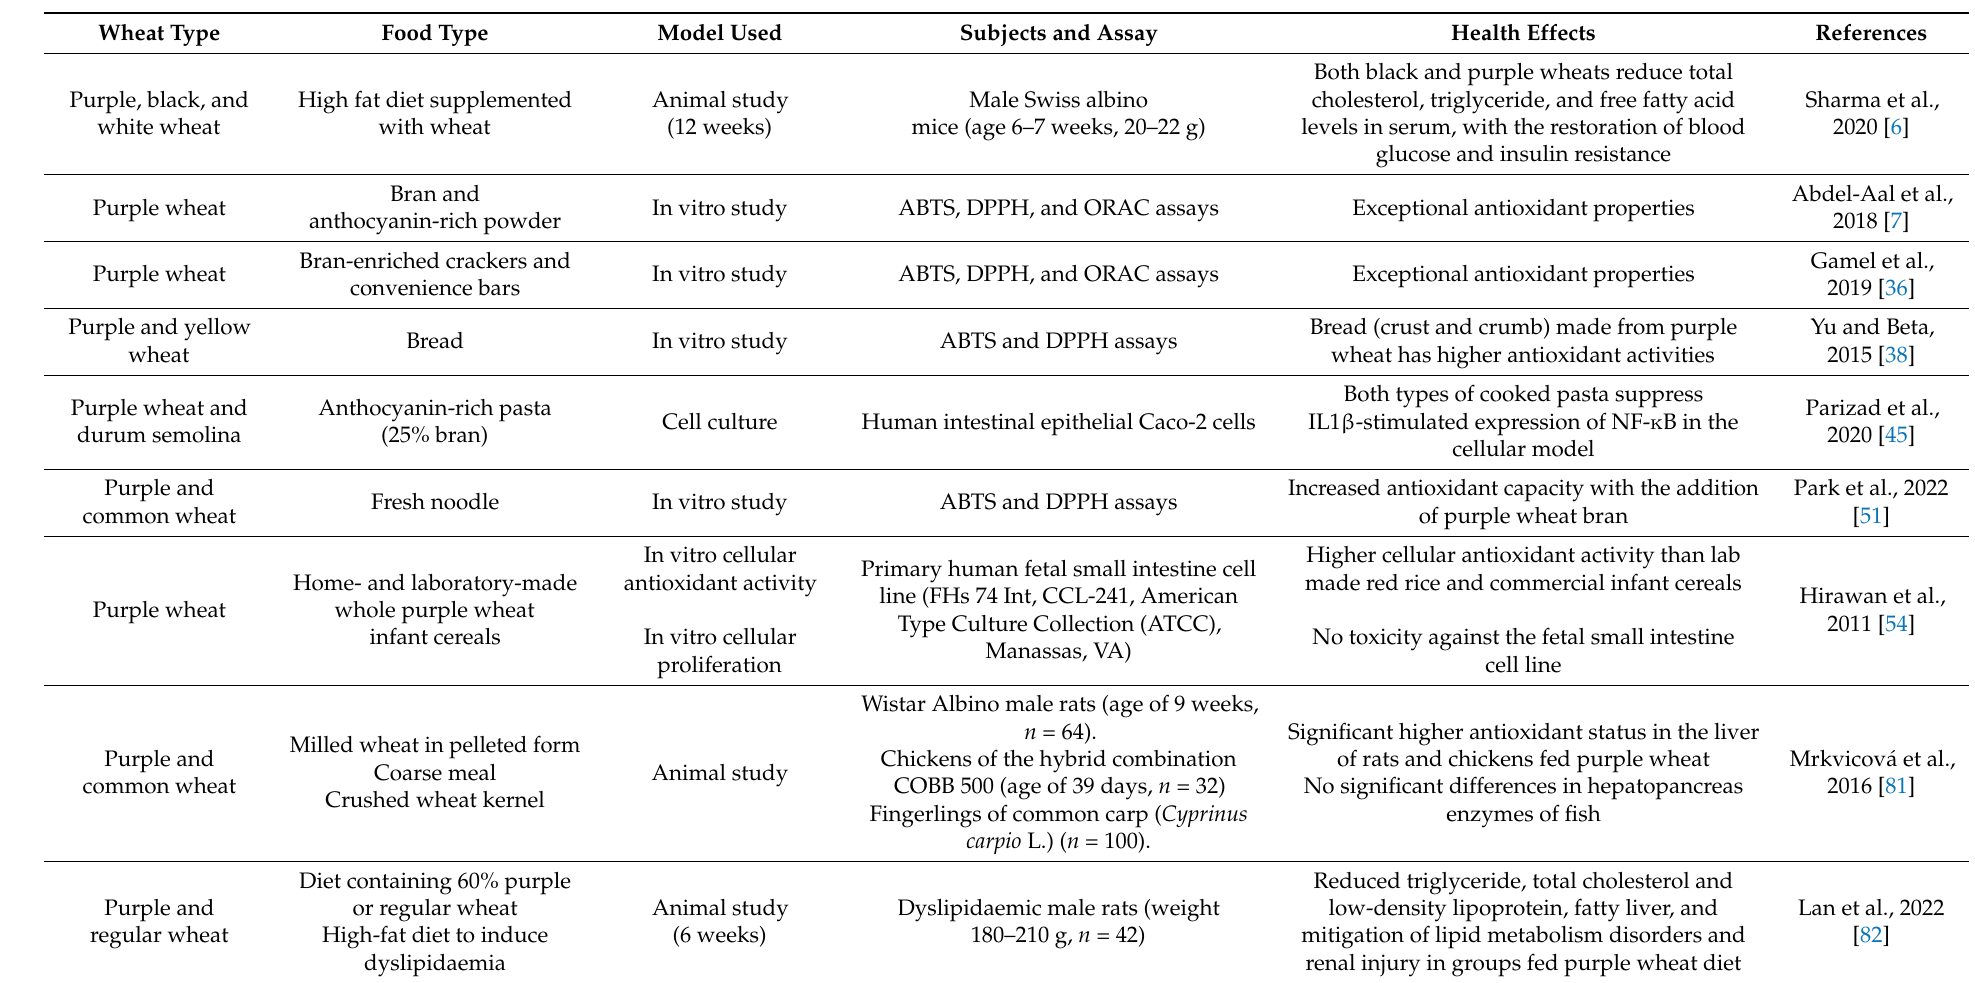
Table 1. Summary of in vitro and in vivo studies conducted on purple wheat